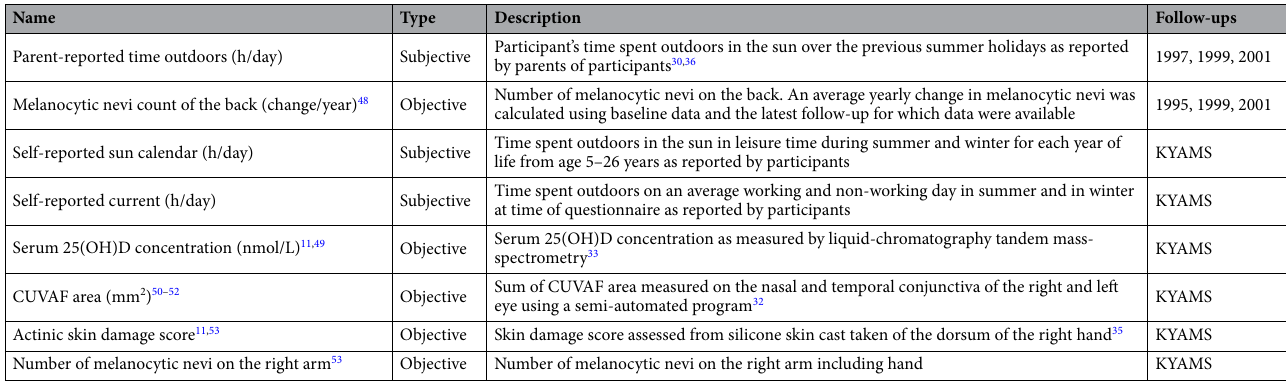
Table 1. Overview of measures of time spent outdoors in the Kidskin Study and the KYAMS Study. 25(OH)D 25-hydroxyvitamin D, CUVAF conjunctival ultraviolet